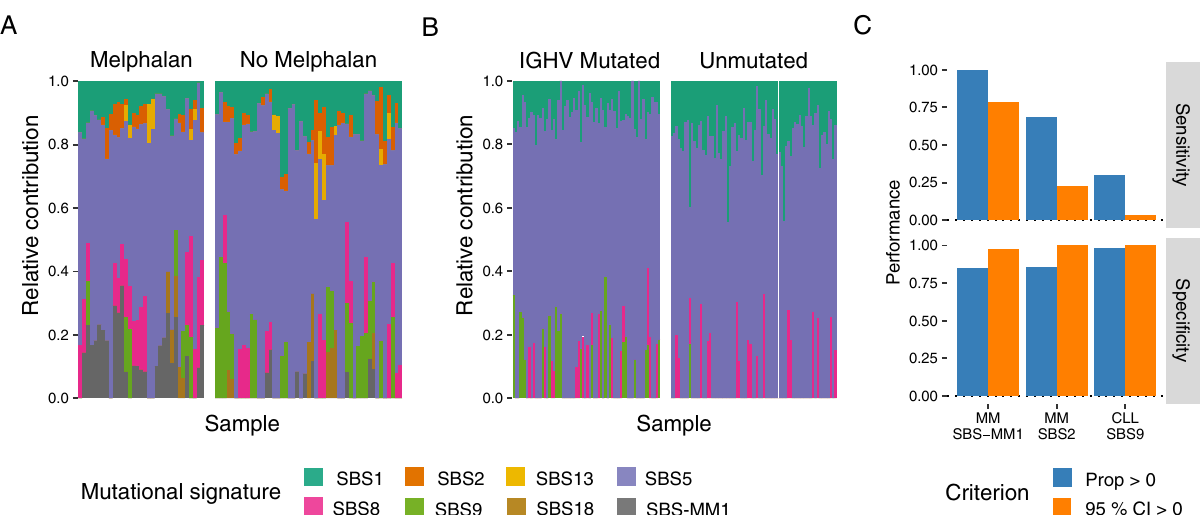
Fig. 8 Mutational signature fi tting applied to whole exomes. Mutational signature contributions in mutations overlapping the SureSelect V6 + UTR exome capture kit in A MM and B CLL samples. Mutational signatures from the full whole-genome sequencing data from the same samples are shown in Figs. 2 and 5, respectively. C Performance of mutational signature fi tting in exome data (shown in A , B ) as compared with the full whole-genome sequencing data as gold